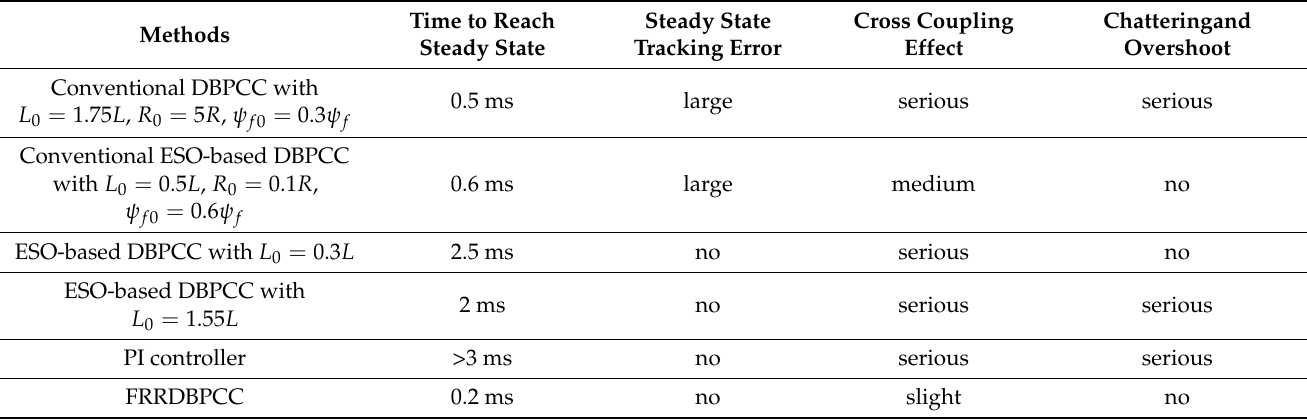
Table 2. Comparison between conventional method and proposed